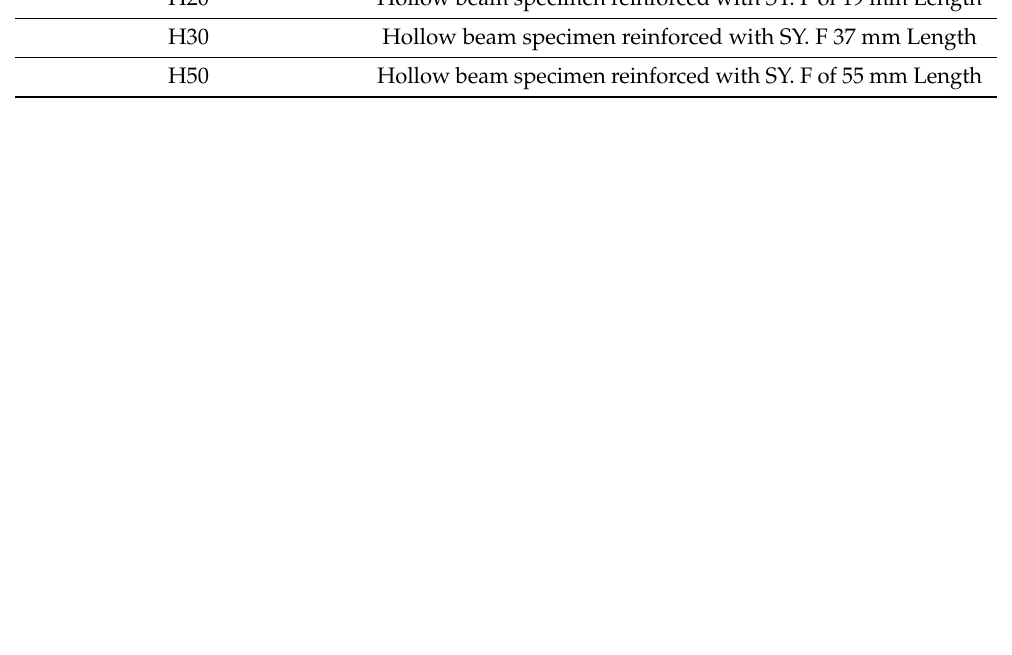
Table 9. Sample IDs